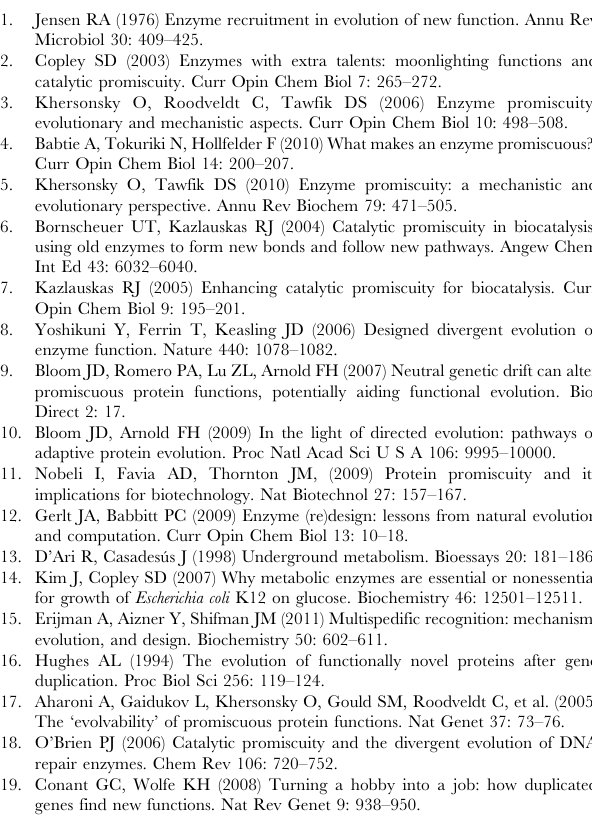
(TIF) Figure S6 Determination of the disulfide reshuffling activity of thioredoxin variants. Plots of recovered RNase activity from disulfide-scrambled protein versus thioredoxin variant concentration. Specific activity is calculated as the slope of these plots. Recovered RNase activity is measured by the initial rate of the change of the absorbance at 288 nm that accompanies the hydrolysis of 2 9 -3 9 -cCMP. Several representative examples are shown, including wild-type thioredoxin from E.coli and several variants, one of which is the P34H variant used as background for library construction. (TIF) Figure S7 Representative examples of partial least squares fits to the 29-variants set. (Figure 5A). Actually, fits to 4 bootstrapping replicas (color-coded) extracted from that set are shown.